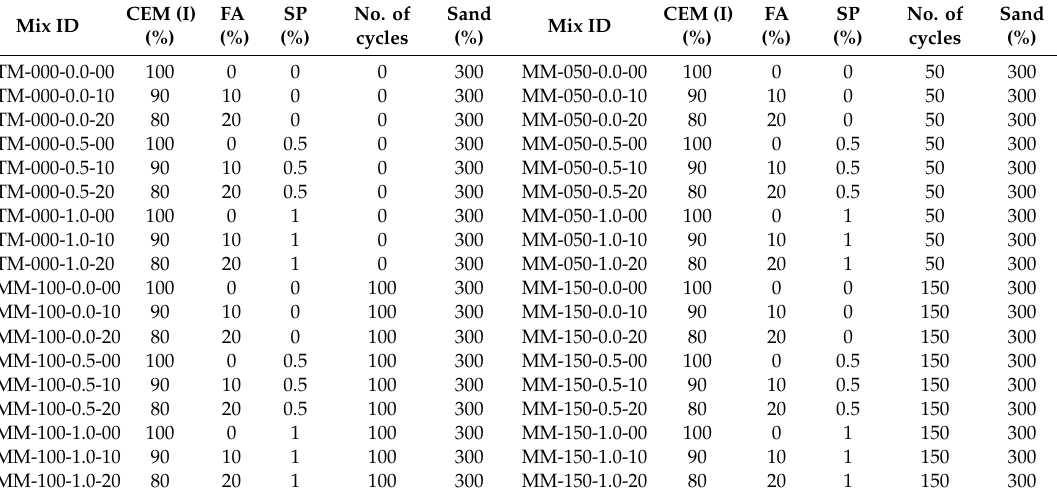
Table 5. Mixture proportions of mortar mixes (% of binders) incorporating (W / B =